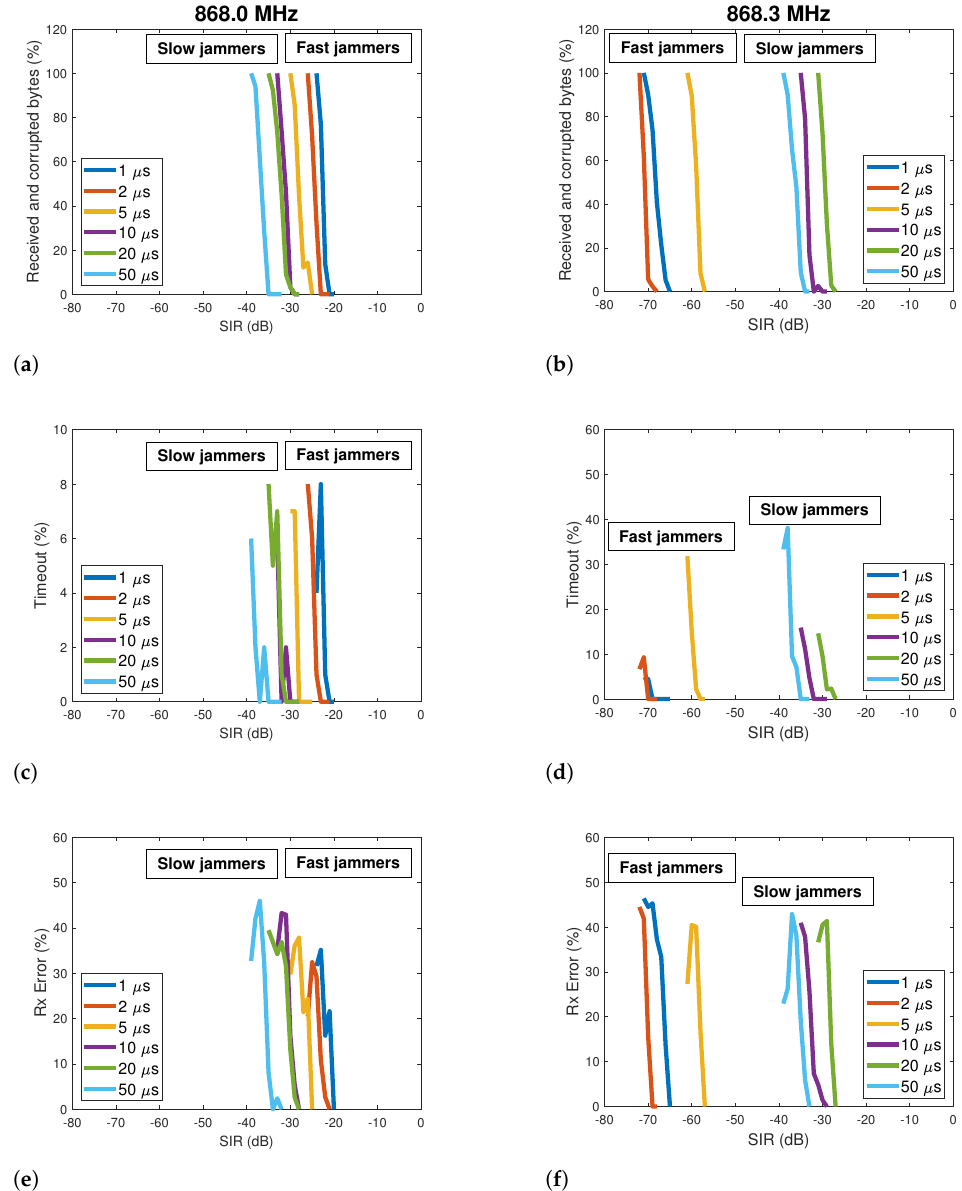
Figure 8. Three different indicators related to the reliability of a LoRa communication link (SF = 7, CR = 4/5, B = 125kHz) under jamming attack. Six different jamming signals were generated, each of them with a particular sweep period. LoRa transmission frequency: 868.0MHz ( a , c , e ) and 868.3MHz ( b , d , f